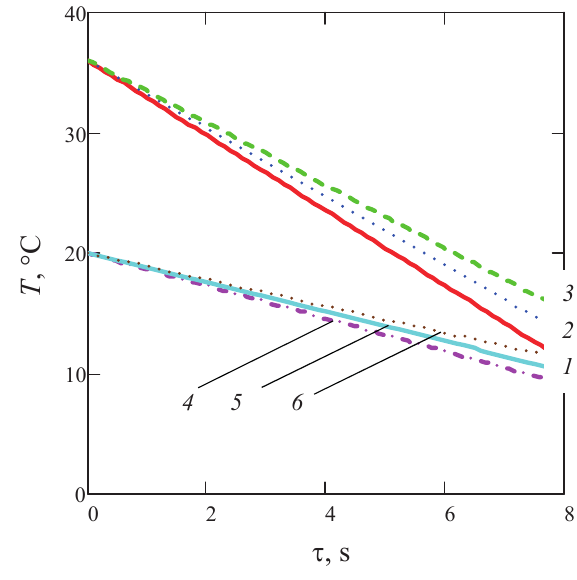
Figure 5 Relation between the outlet temperature of liquid Т and time τ at different values of parameters ( z = 0.5 m;